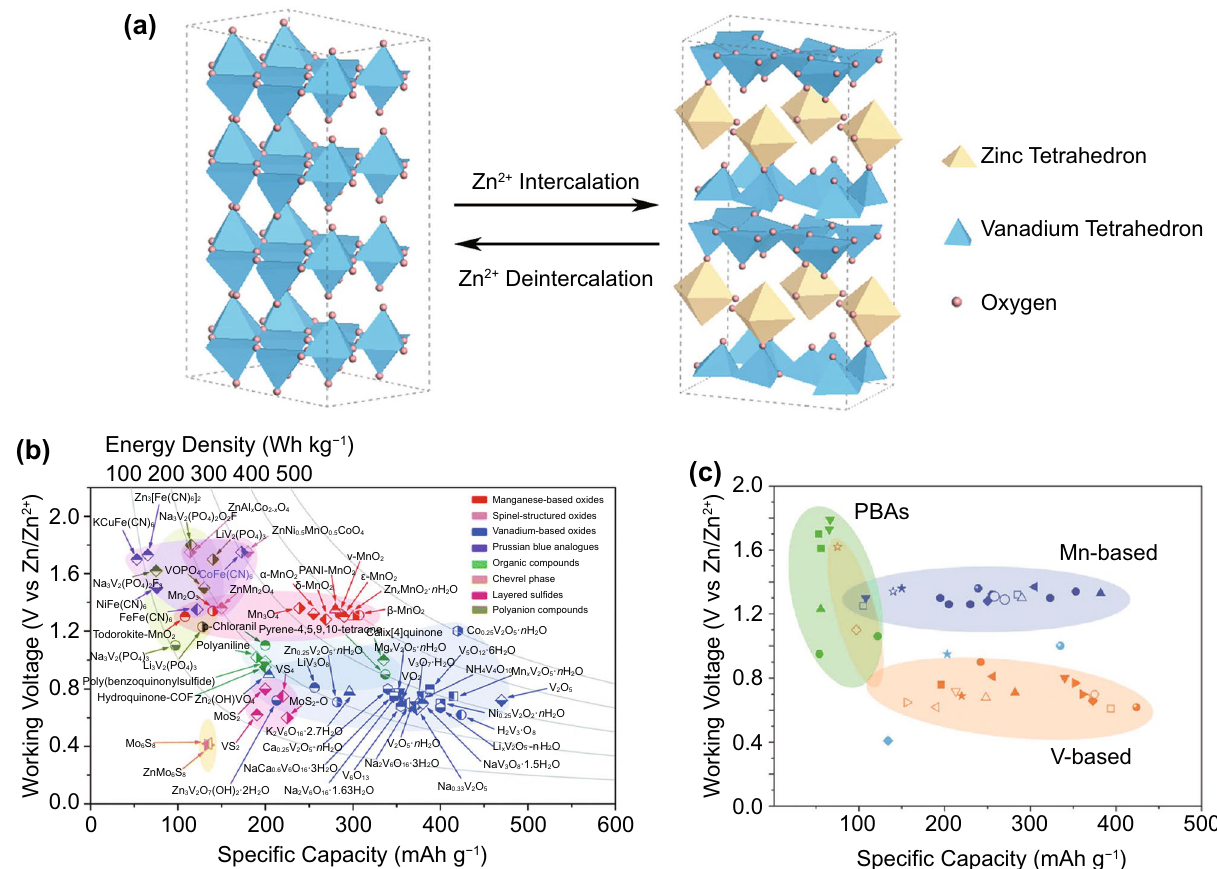
Fig. 9 a Schematic of Zn ion insertion into a representative V 2 O 5 cathode framework. b, c Cell voltages and charge capacity of various cathodes for ZIBs. Reproduced with permission [105, 107] . Copyright 2021, Elsevier. Copyright 2020, Royal Society of